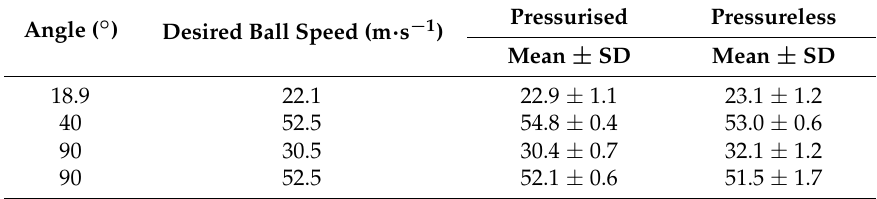
Table 4. Mean pre-impact ball speed ± one standard deviation (SD) for impact conditions of